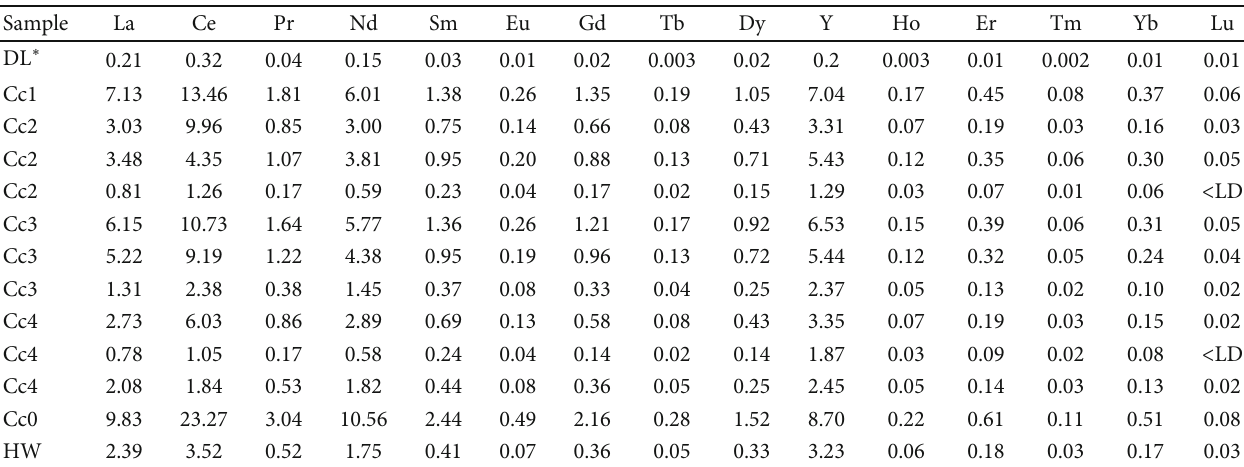
Table 3: REE and Y contents of the di ff erent calcite cements (Cc1 to Cc4), the interparticle cement Cc0 from the footwall (FW), and the host rocks from the hanging wall (HW). Values are given in ppm. ∗ DL: detection limit.